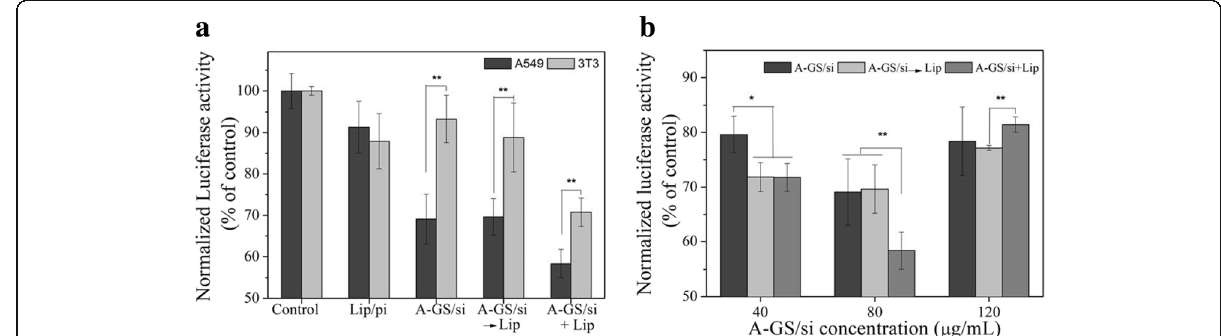
Fig. 7 In vitro silencing effect of anti-luciferase siRNA formulated in Apt-GS nanogels with different treatments ( a ) and concentration of Apt-GS/ siRNA complexes (A-GS/si) on gene silencing ( b